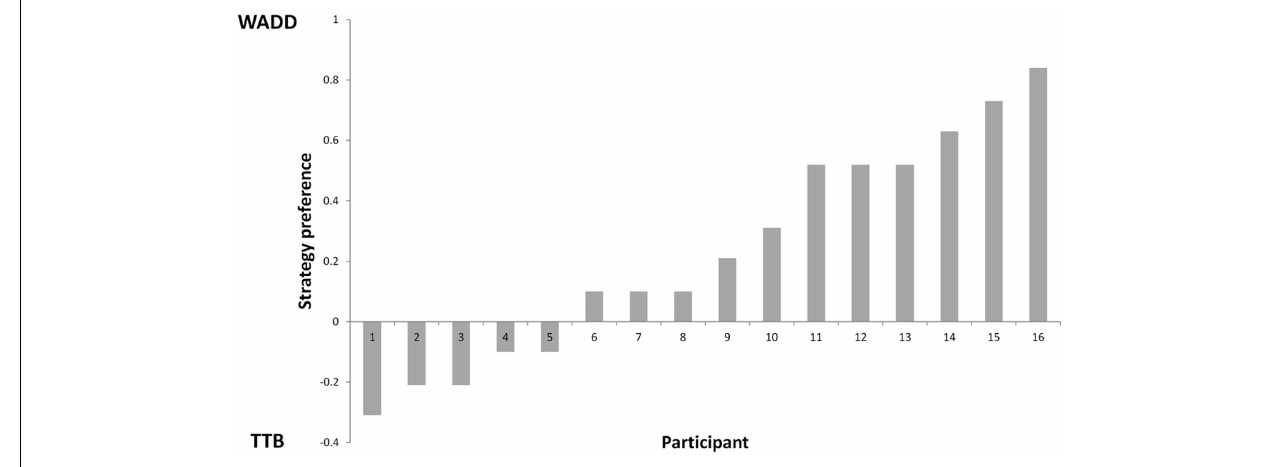
FIGURE 2 | Preference for WADD and TTB strategy across